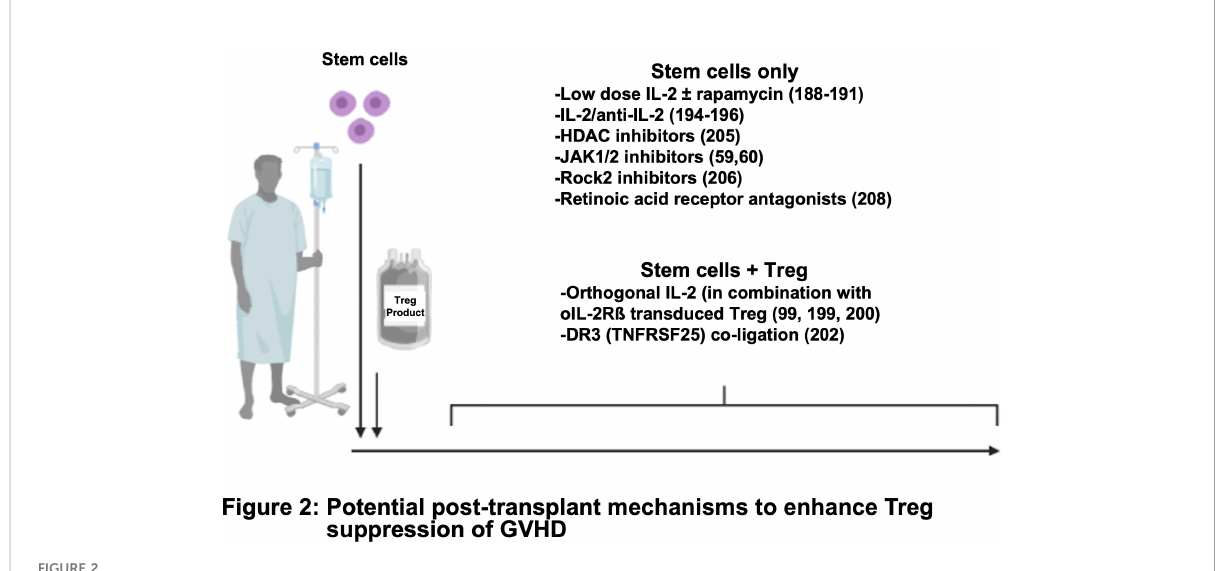
FIGURE 2 Potential post-transplant mechanisms to enhance Treg suppression of